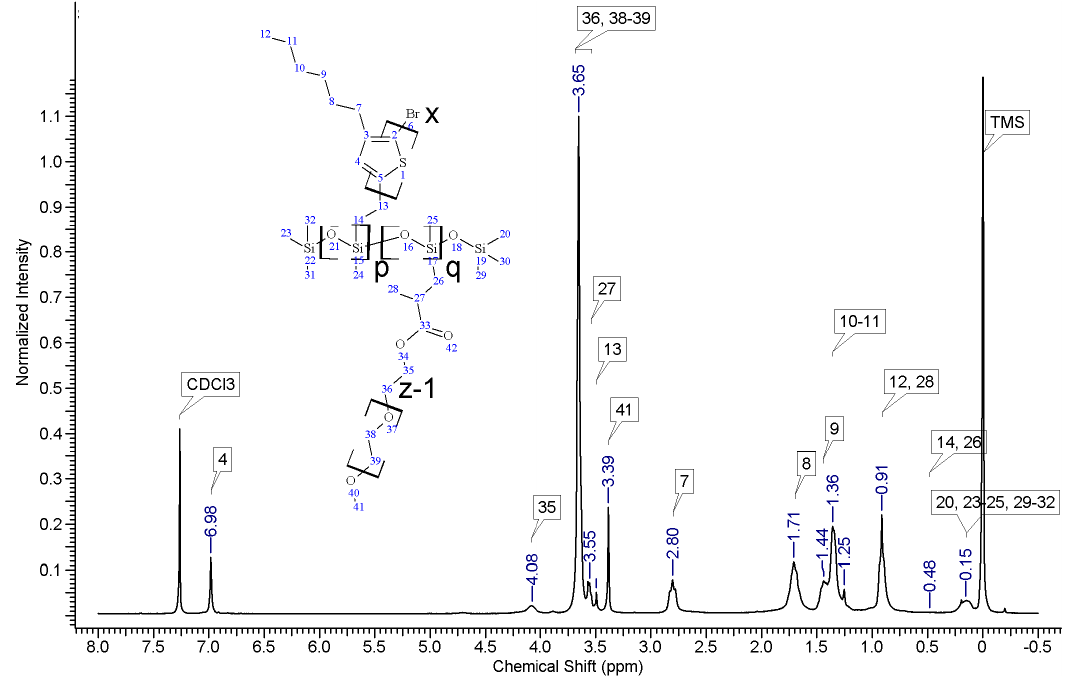
Figure A5. spectrum of poly(methylsiloxane)-graft-[poly(3-hexylthiophene); poly(ethylene glycol) (composed of chloroform fraction of vinyl terminated poly(3-hexylthiophene), poly(methylhydrosiloxane) average M n ≈ 1700–2300; chloroform fraction of graft copolymer) ( P3HT-Sil-PEG3 ).